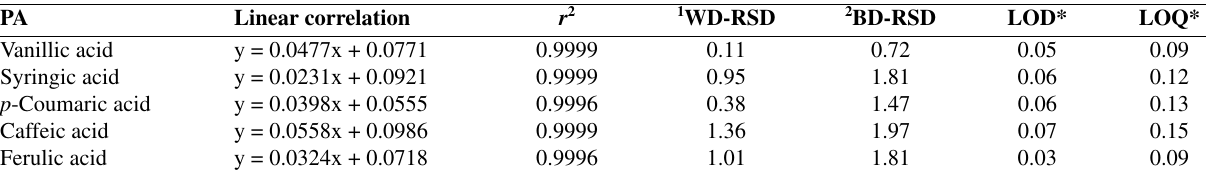
Table 4. Validation parameters for investigated PAs. PA Linear